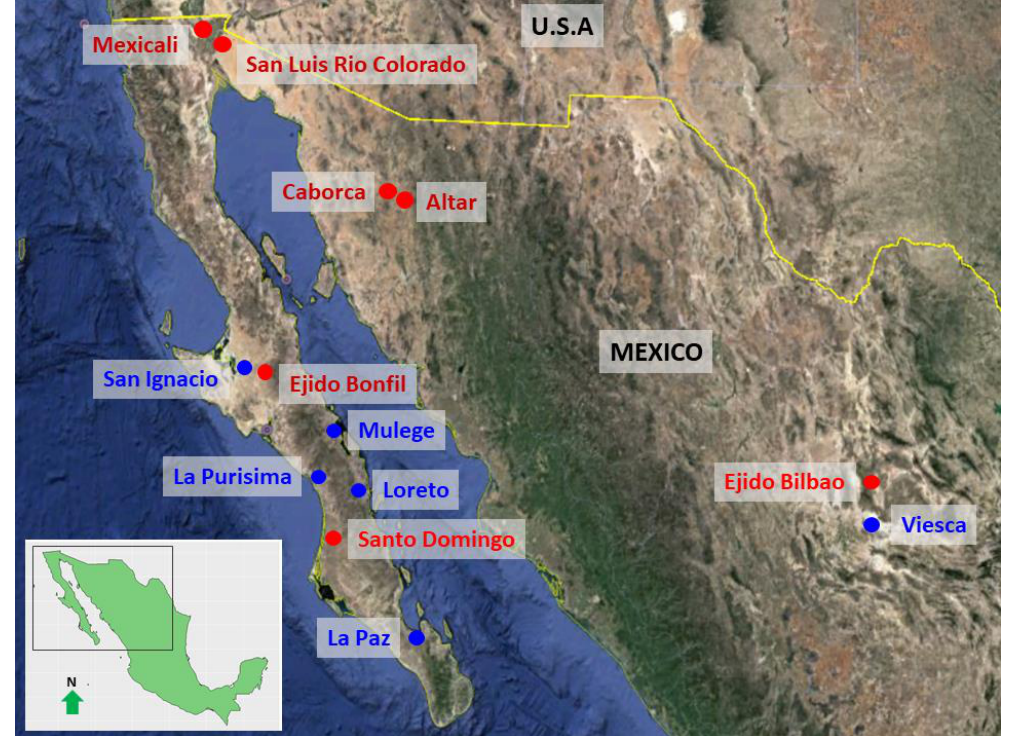
Figure 1. Areas in red, grow high-value commercial cultivars. Areas in blue, cultivate criollo dates.